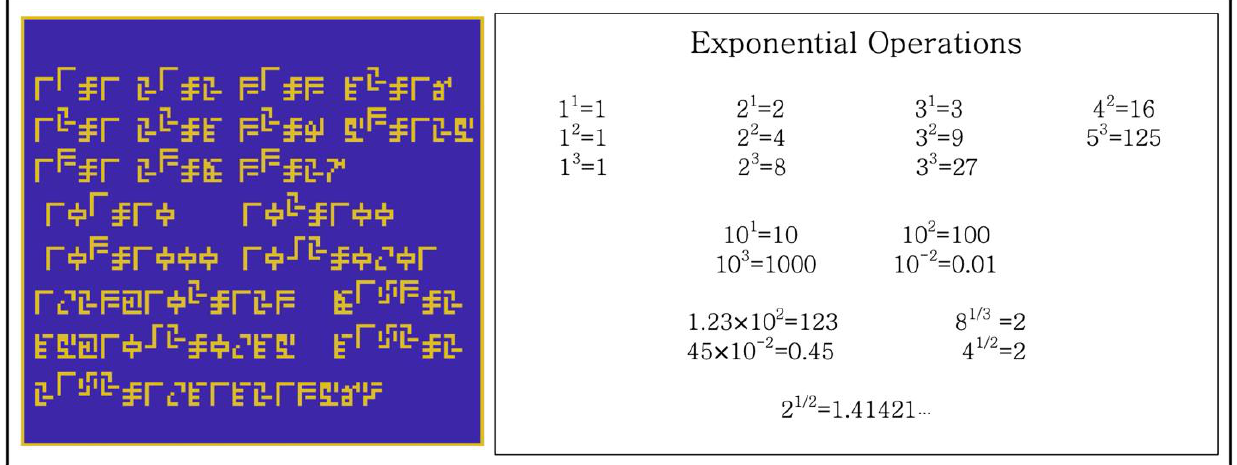
Figure 8. Pictural representation and explanation of the meaning in the Message, page 2.